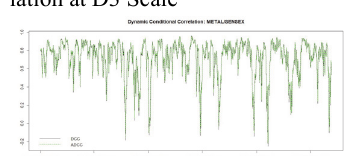
Fig. 11. Dynamic Conditional Corre- lation at D6 Scale